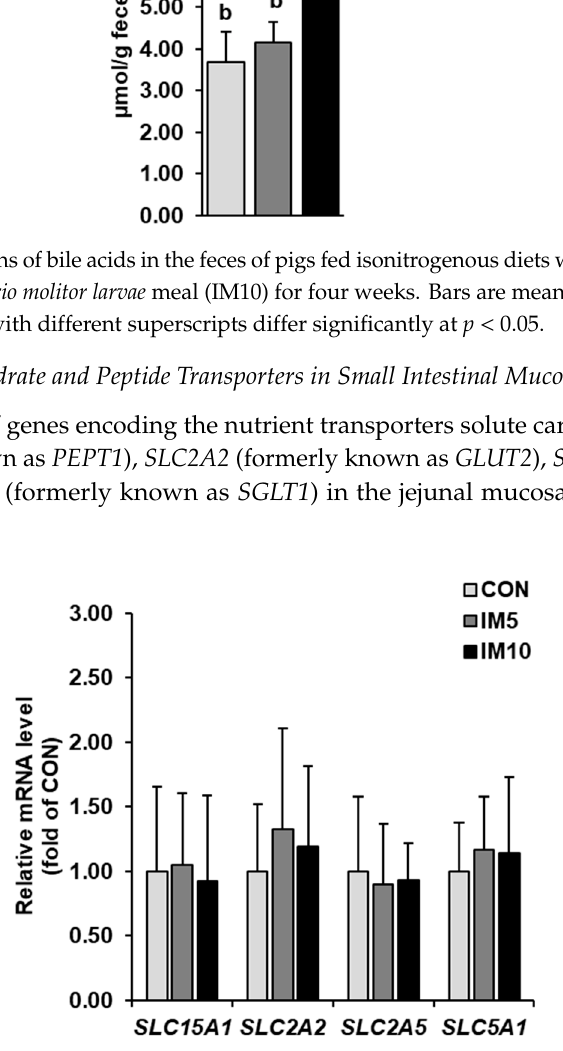
Figure 4. Concentrations of short-chain fatty acids (SCFA) in the cecal digesta of pigs fed isonitrogenous diets without (CON) or with 5% (IM5) or 10% Tenebrio molitor larvae meal (IM10) for